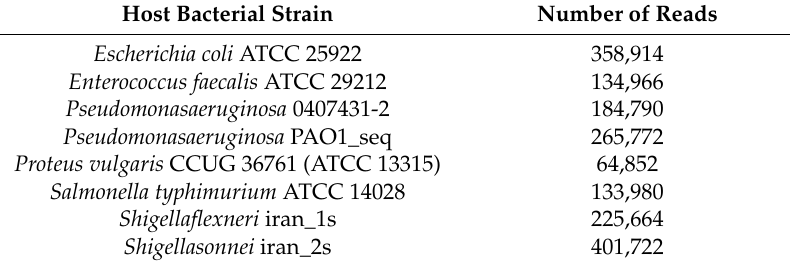
Table 1. List of the strains used to specifically amplify phages from the Intesti cocktail and the number of reads obtained in their sequencing. All strains were tested for susceptibility to the cocktail prior to selection. Host Bacterial Strain Number of